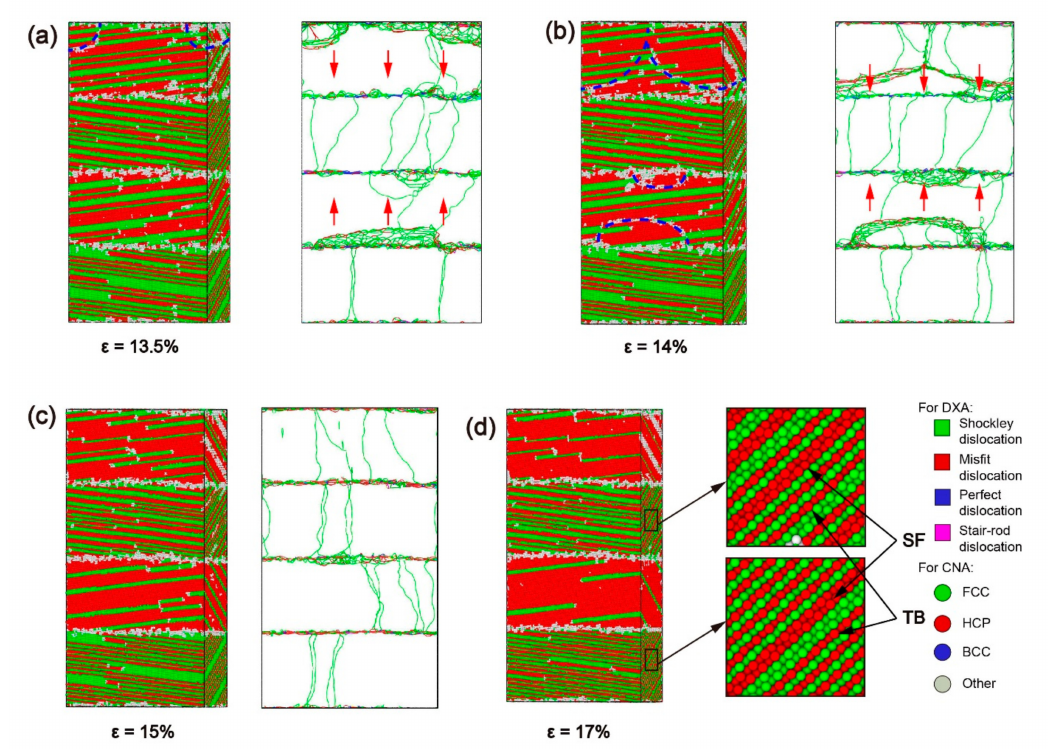
Figure 10. The common neighbor analysis (CNA) and dislocation analysis (DXA) of the model with α = 80 ◦ under di ff erent strains ε : ( a ) ε = 13.5%, ( b ) ε = 14%, ( c ) ε = 15%, and ( d ) ε =